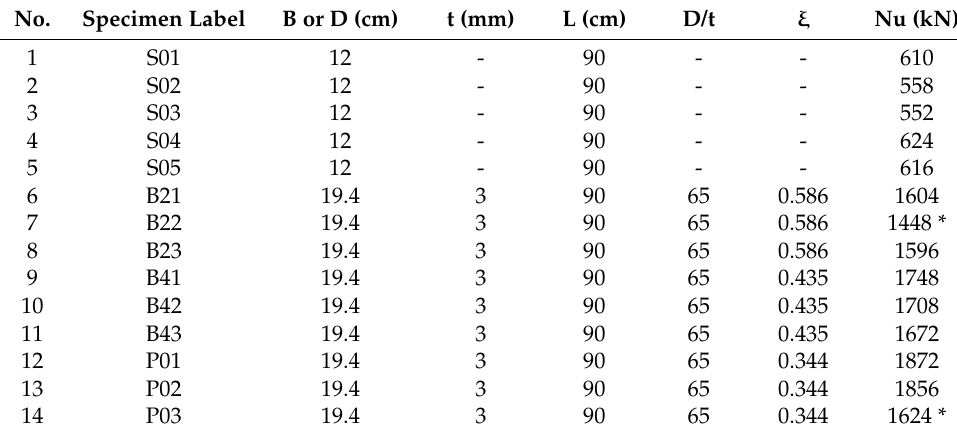
Table 1. Specimen labels and summary of test information.